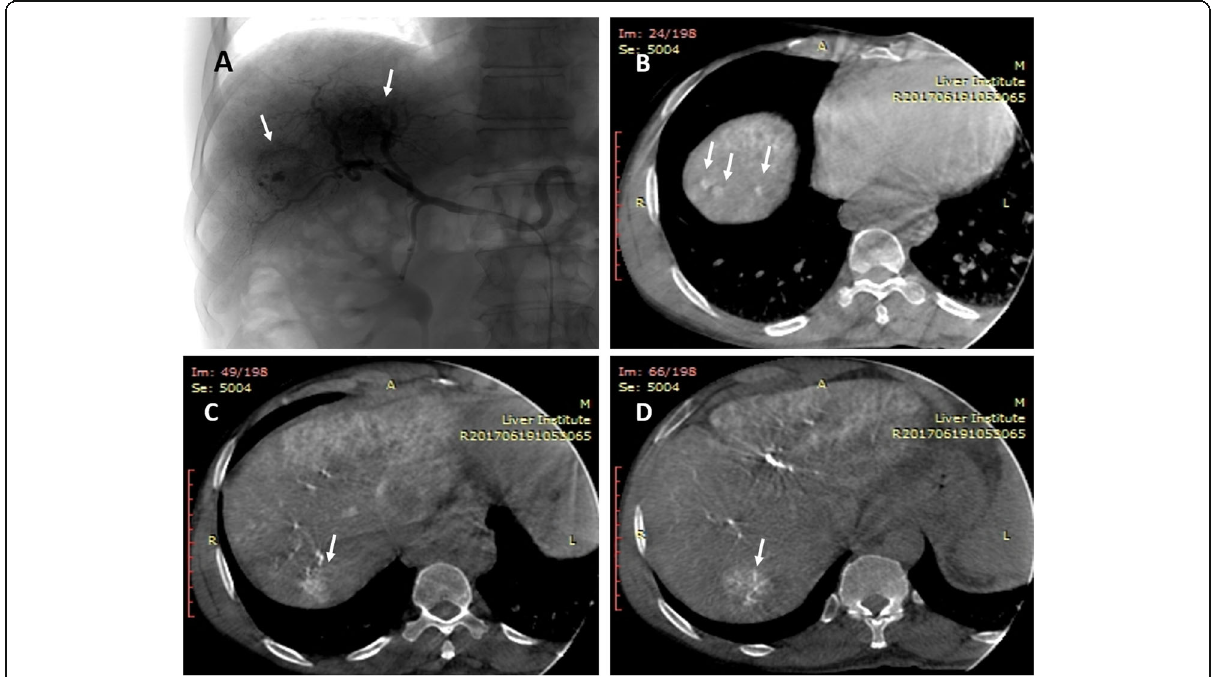
Fig. 5 A 66-year-old male patient diagnosed to have three HCC focal lesions by laboratory and imaging criteria referred to do TACE. a Non- selective angiography of the main right hepatic artery revealing the vascular anatomy of the right hepatic artery up to fourth-order branches as well as two enhanced focal lesions (arrows). b – d Axial CBCT-HA at different levels from superior to inferior demonstrating five focal lesions, three of them were not seen by angiography or any imaging modality, the size of the smallest one was 6